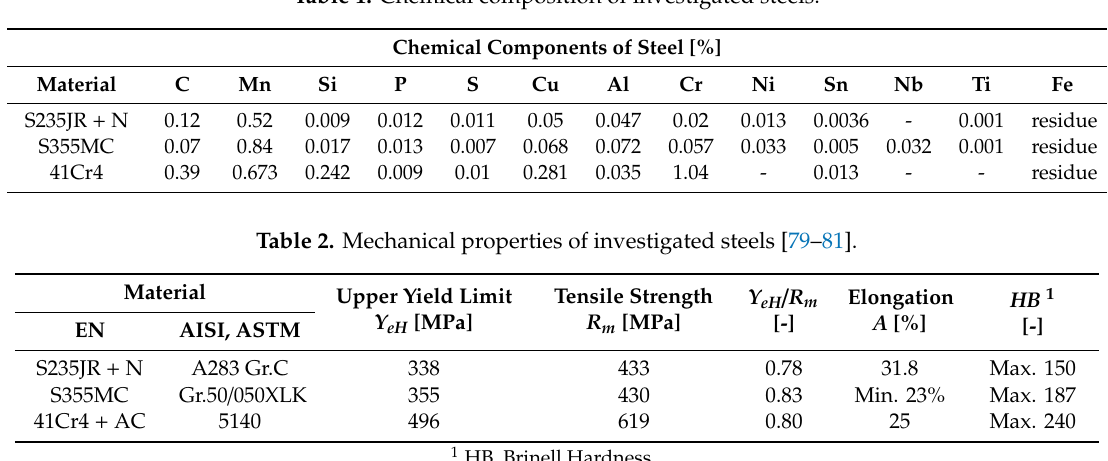
Table 1. Chemical composition of investigated steels.